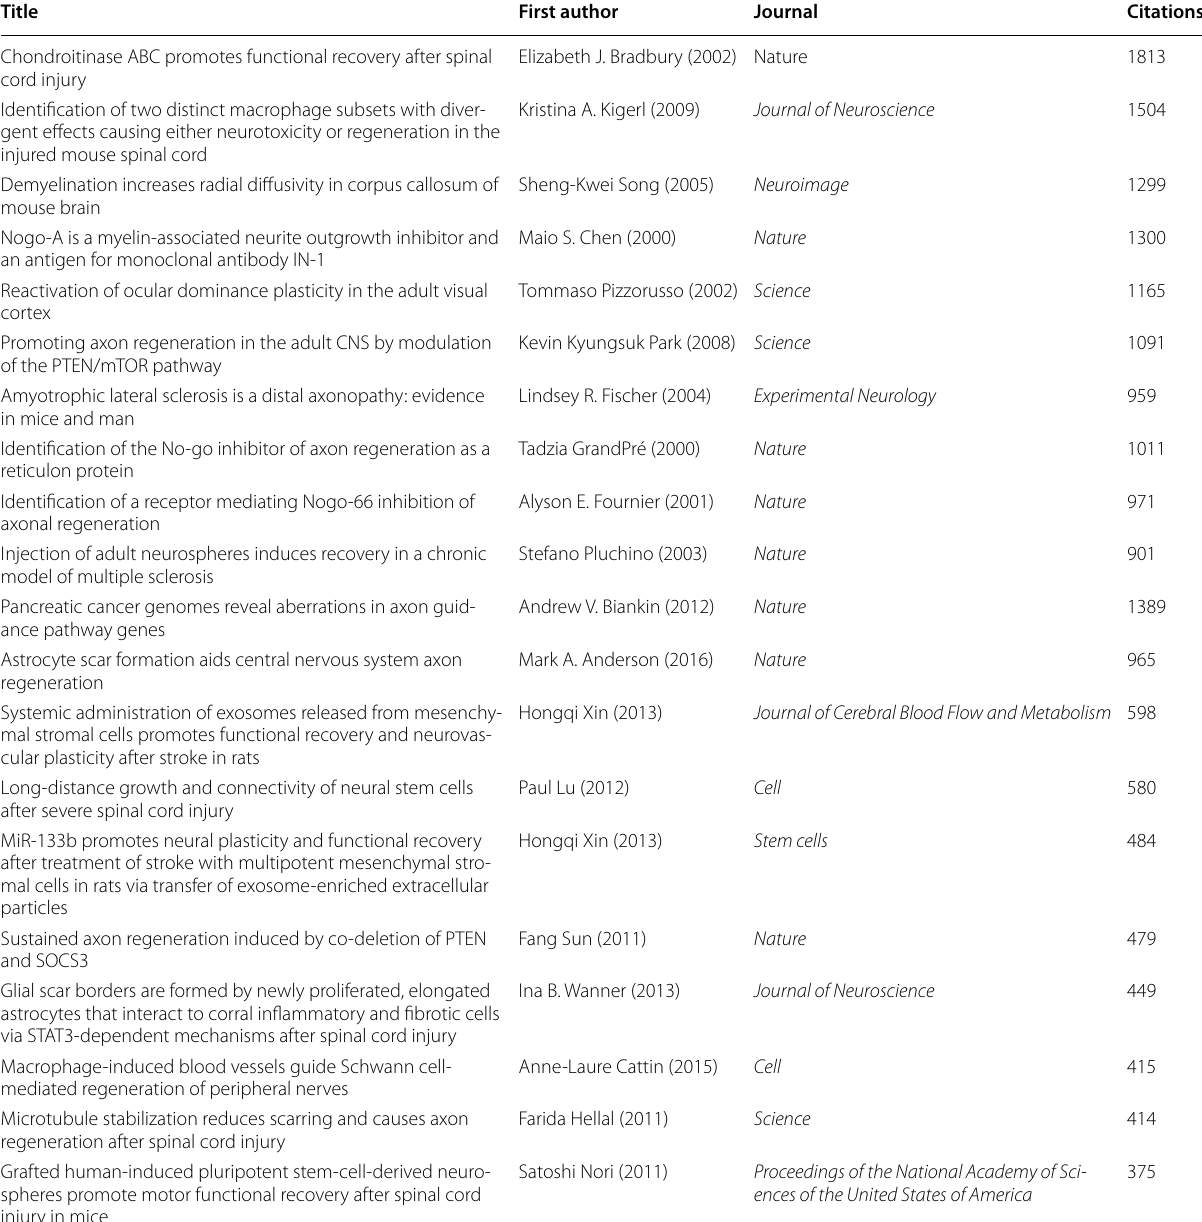
Fig. 9, highlighting the topics of interest and their inter- relationship. The number of publications per topic was represented by topic bubble size, while the magnitude of associations between topics was depicted by the network line width. Thirty-five LDA-derived topics were divided into 3 topic network clusters based on the